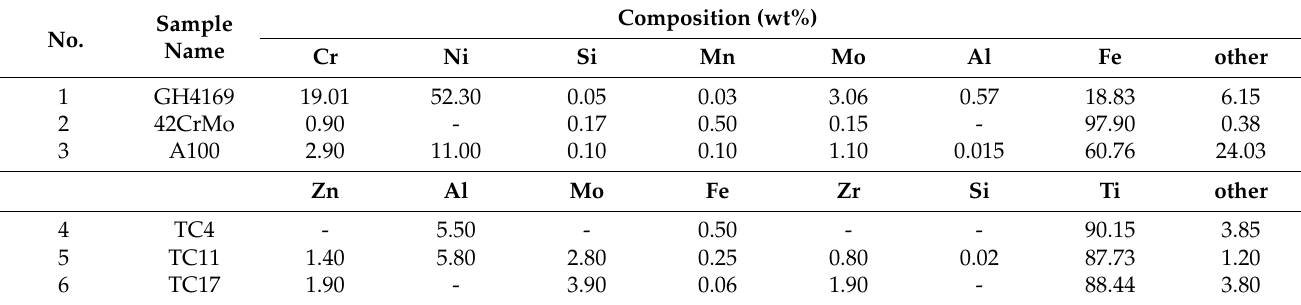
Table 1. Concentration information of examined elements in six aviation alloy samples.